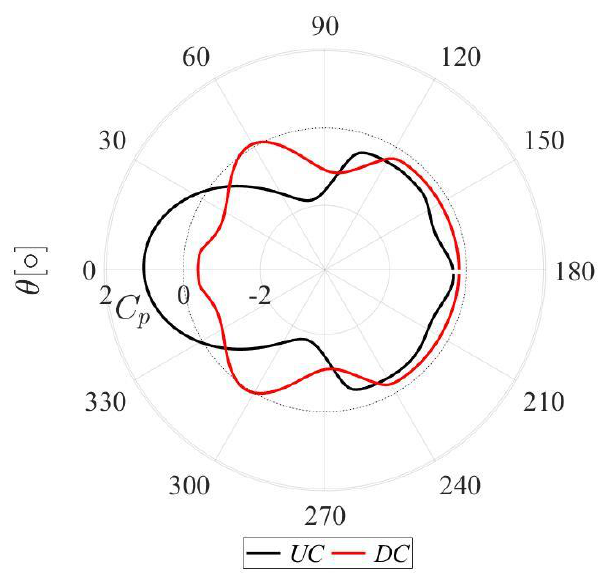
(cid:16) (cid:17) 1 𝜌𝑈 2 ), where 𝑝 1 ρ U 2 , where p 0 is 0 is 2 2